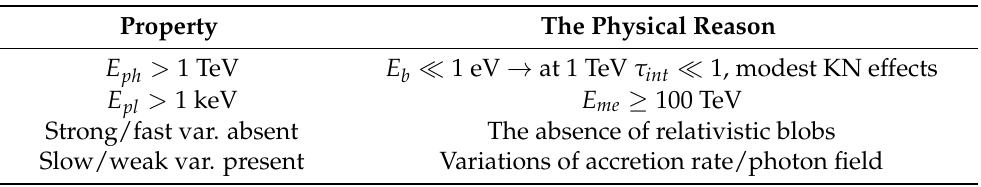
Table 2. Explanation of the peculiar properties of ETBs in the framework of the proposed model. Property